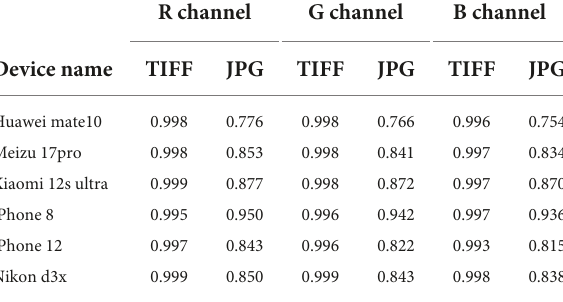
TABLE 2 R -squared values for each channel of TIFF and JPG for six imaging